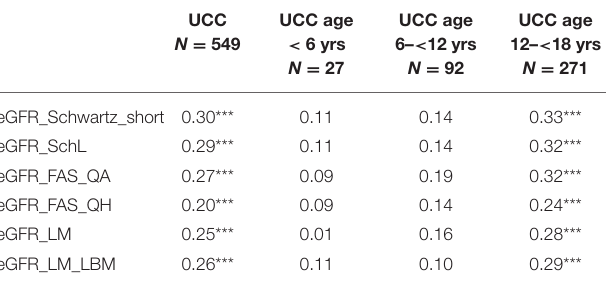
TABLE 3 | Spearman correlation coefficients for eGFR and UCC, all patients, and age groups.